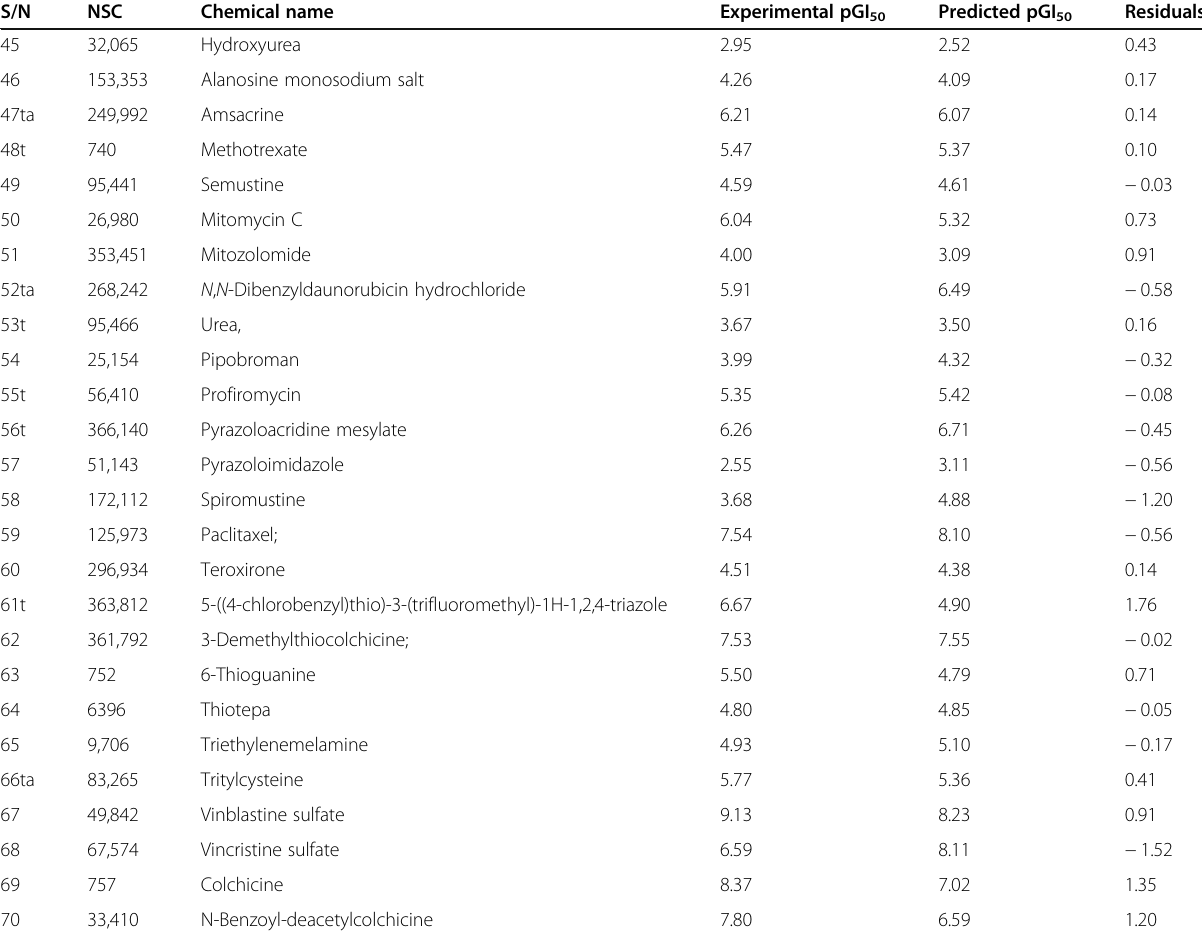
Table 1 NSC numbers, chemical names, experimental and predicted pGI 50 of the dataset with residuals (Continued) S/N